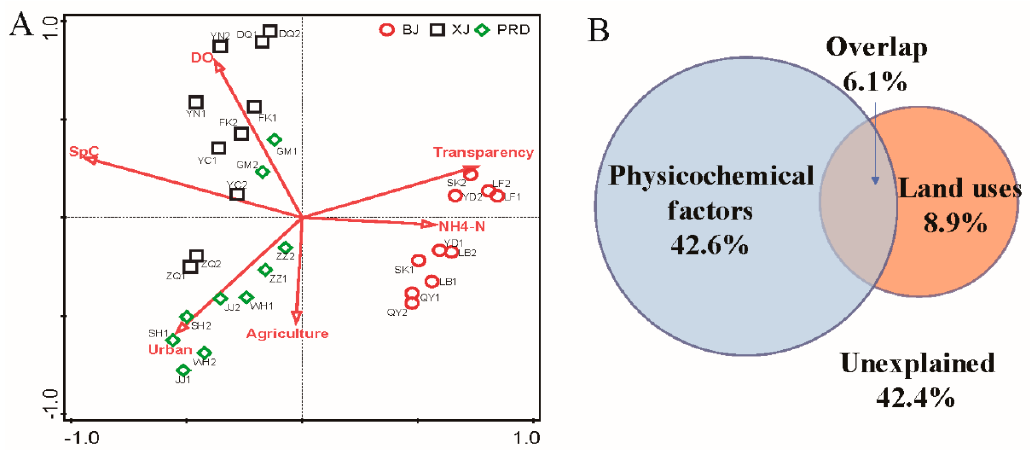
Figure 7. E ff ects of physicochemical variables and land use on bacterioplankton communities. ( A ) Redundancy analysis (RDA) ordination showing associations between bacterioplankton and environmental factors in the Pearl River. ( B ) Variation partitioning of bacterioplankton communities by physicochemical variables and land use.